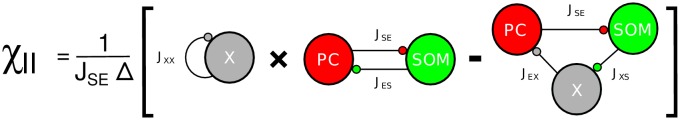
Model 2.Graphical representation of χII (large N,K limit). Note : χEI=JSIJSEχII.